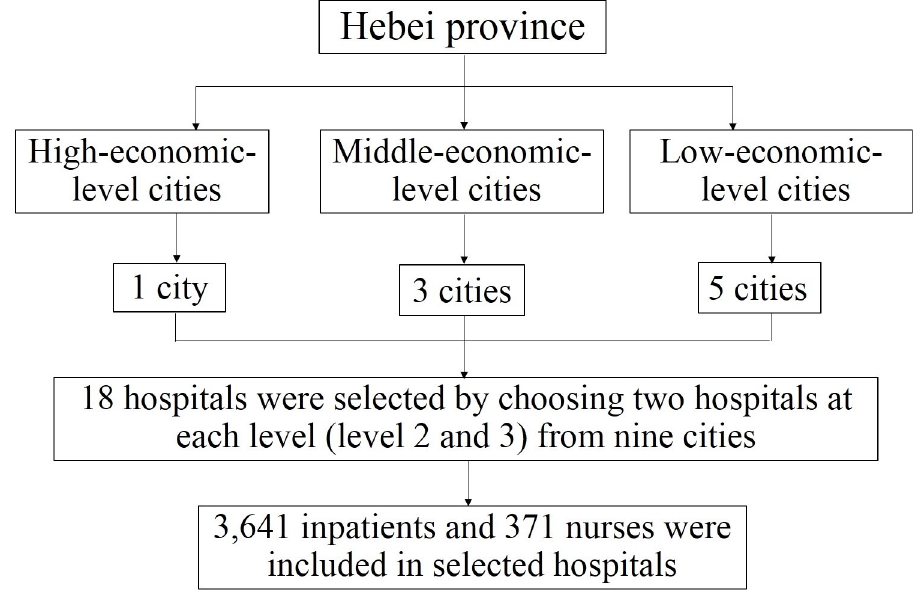
Fig 1. Heibei province study profile of patients’ favorite type of nursing